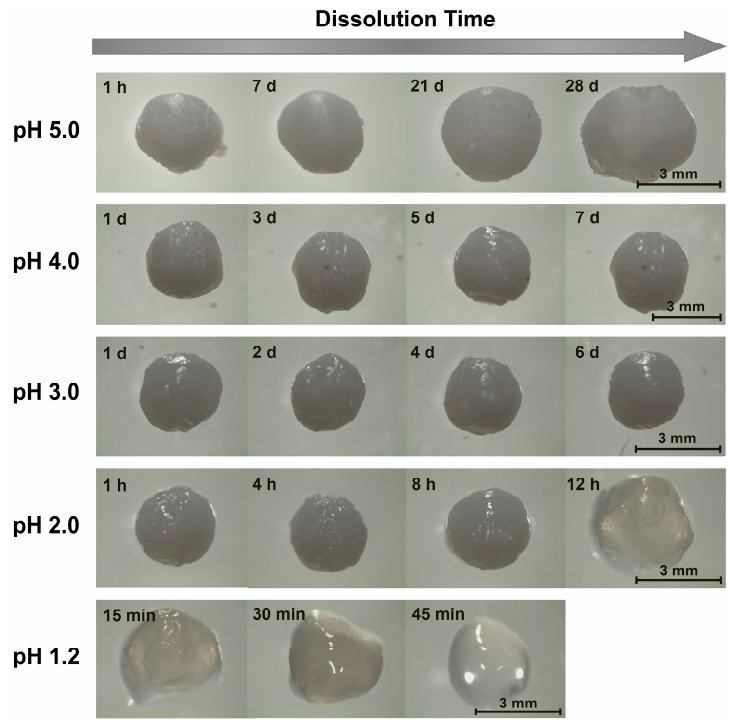
Figure 3. Representative images of chitosan/TPP beads dissolving in pH 1.2–5.0 aqueous solutions ([NaCl] = 10 mM).